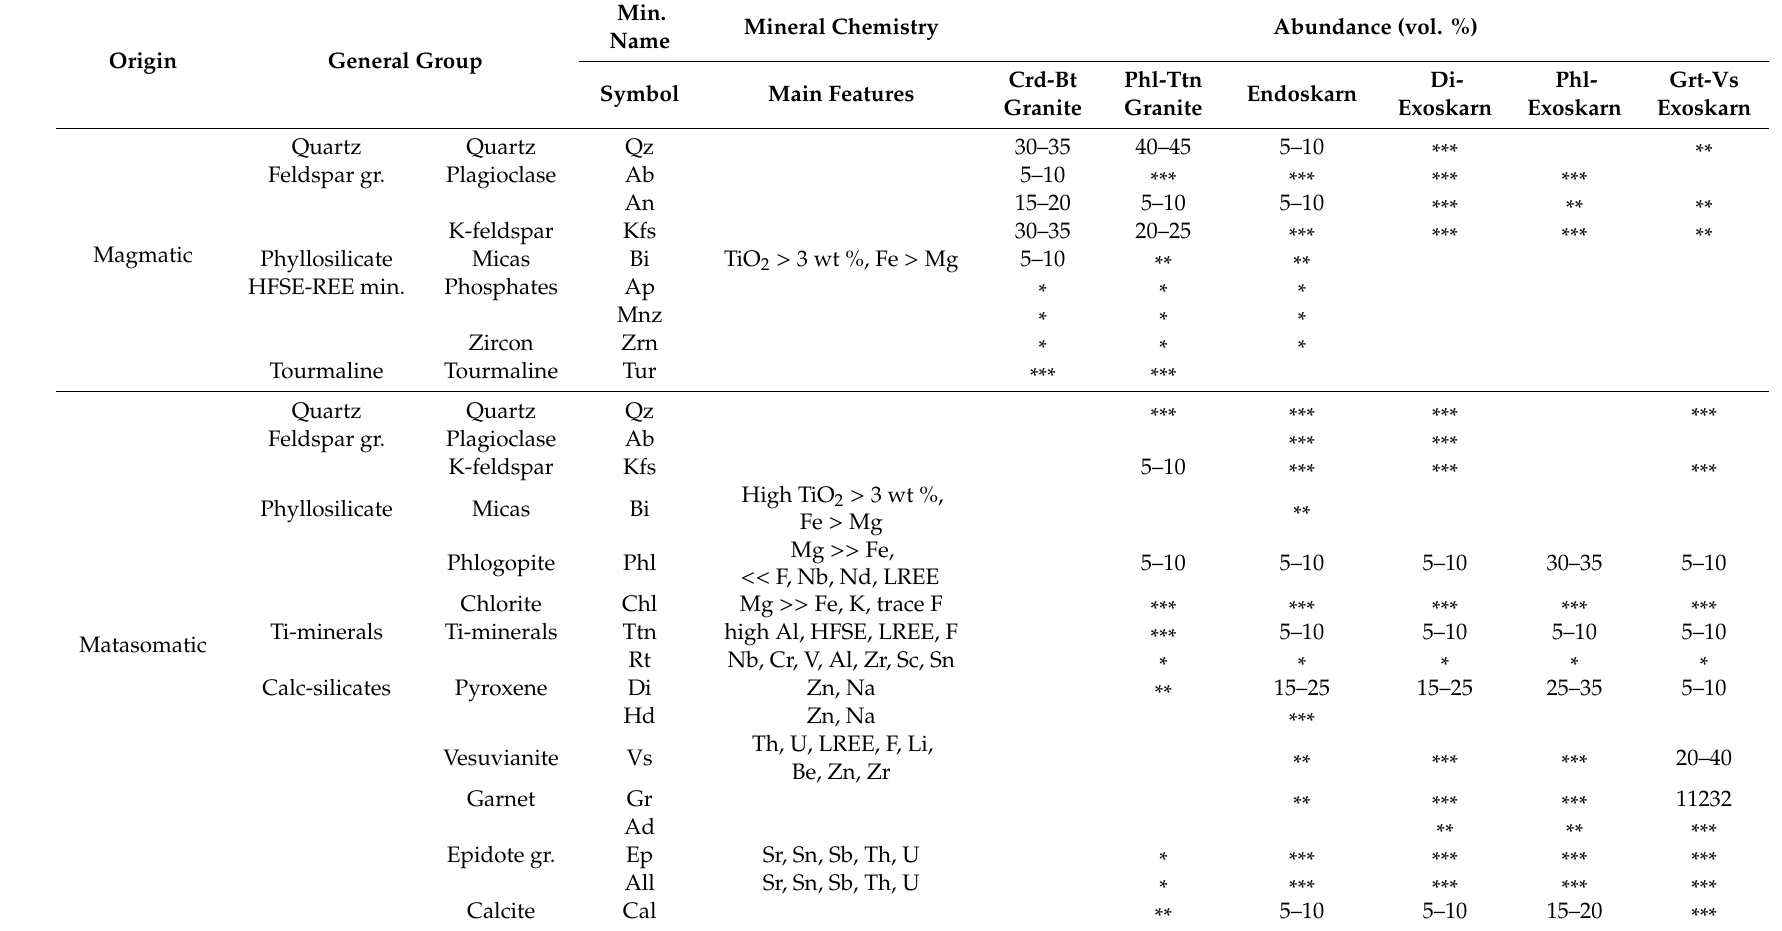
Table 1. Main metasomatic minerals observed in the Campiglia